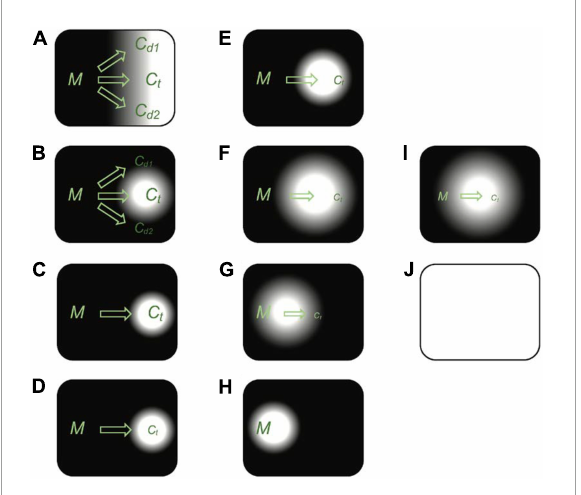
FIGURE2 A depiction of the variety of Tantric Yoga meditative states of consciousness. The shades of white and black depict the components of consciousness that are salient and pre-reflective, respectively, to the first-person. The different sets of panels in the three columns are meditation states arrived through reduction of citta , ahamtattva , and mahattattva , respectively. (A) At the beginning stage the mental object includes several distractions (Cd1, Cd2, ... ) along with the meditative target (Ct). The target along with distractions are thus salient along with a feeling of doership, agency, or ownership of one’s mental actions on the mental object. This is depicted by white Cs and partly white arrows. (B) Concentrative practices ( dharana ) enable selective enhancement of Ct’s saliency. (C) Mental withdrawal ( pratyahara ) practices diminish distractions, making Ct even more salient. (D) Continuous sustained attention on Ct makes it qualitatively more subtle, almost as if receding into a blank background. (E) With citta reduced, the feeling of the act of meditating becomes salient – illustrated by the leftward movement of the white spot encompassing more of the arrow. (F) The mental act and object start to diminish within consciousness – illustrated by the smaller size of the arrow and Ct. (G) Almost at the same time as (F) , there is a conscious experience with a diminished sense of the act of meditation upon the mental object – illustrated by the white spot moving leftwards to cover M. (H) Mental act and object are eliminated from consciousness with only a bare existential consciousness remaining – Savikalpa Samadhi . (I) Phenomenological attempts to suspend all aspects of conscious experience including the mental act, mental object, and a sense of existentiality, into an idea of a